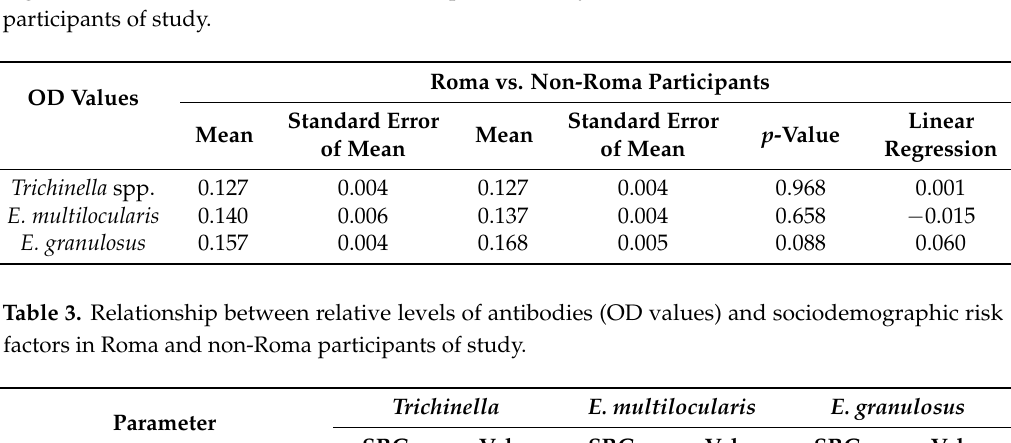
Table 2. Results of statistical analyses ( t -test, Analysis of Variance (ANOVA) and univariate linear regression) of results of ELISA method (optical density (OD) values) in Roma and non-Roma participants of study.